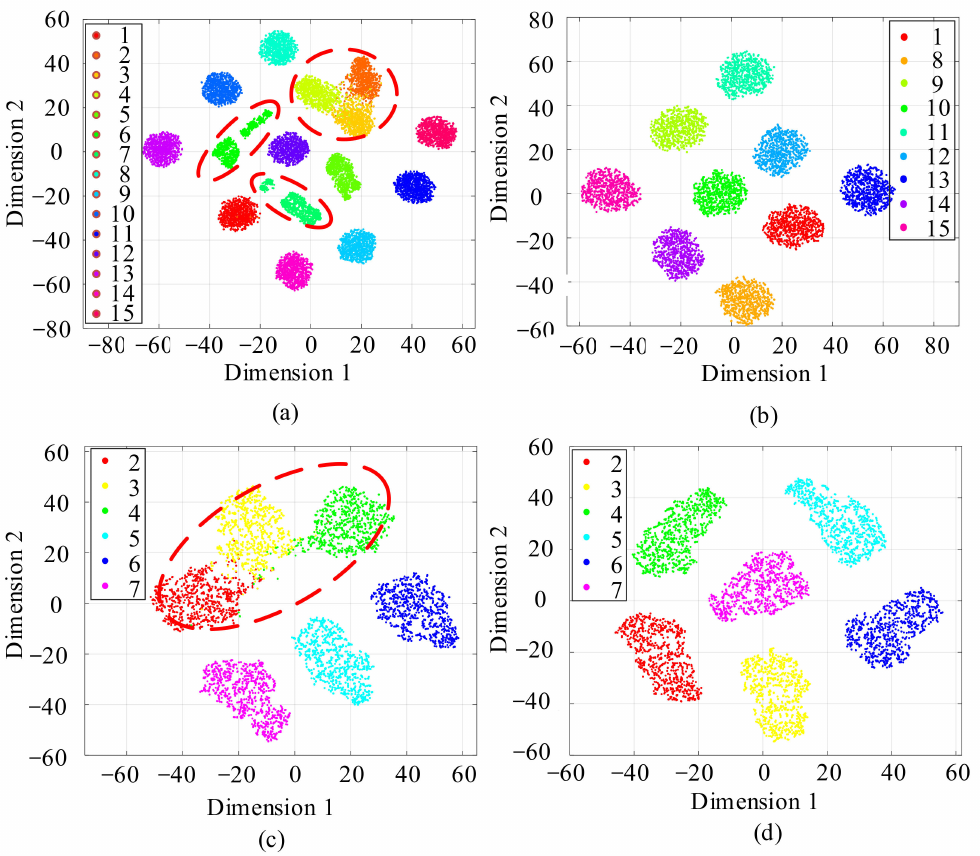
Figure 9. Visualization results of the features extracted under different layers based on t-SNE: ( a ) result of all faults under 1-layer; ( b ) result of open-circuit fault and healthy state under 2-layer; ( c ) result of current sensor fault under 2-layer; ( d ) result of current sensor fault under